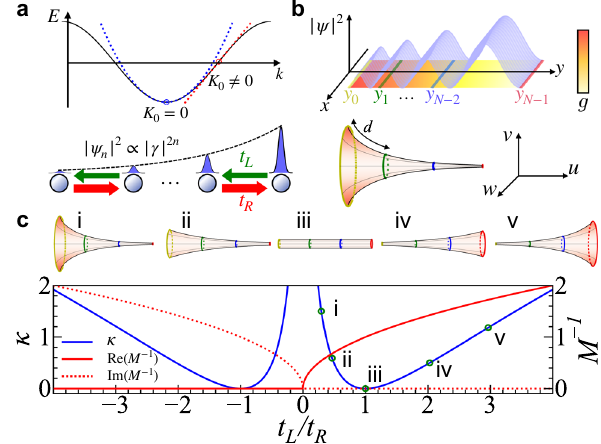
Fig. 1 The duality between the Hatano-Nelson (HN) model and a hyperbolic surface. a A HN chain and its energy spectrum as a function of k . Near a vanishing ( fi nite) K 0 , the effective theory in curved space is non- relativistic (relativistic). Eigenstates on the HN chain are localized at the edge, ∣ ψ n ∣ 2 ∝ ∣ γ ∣ 2 n . b A HN chain is mapped to the shaded strip on the Poincaré half-plane, in which an eigenstate with k x = 0 satis fi es ∣ ψ ∣ 2 ∝ y . This shaded strip on the Poincaré half-plane with PBC in the x -direction is equivalent to a pseudosphere embedded in 3D Euclidean space. c The curvature and the inverse of the effective mass, as functions of t L for a fi xed t κ and M − 1 are 1/ d 2 and 2 t d 2 /( ℏ 2 ), respectively. (i – v) show R . The unites of R the dual pseudospheres of the HN model at various t L > 0. A pseudosphere for t L < 0 is the same as that for − t L